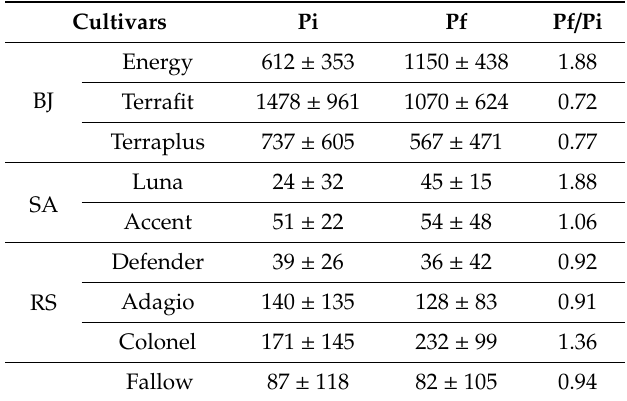
Table 1. Initial (Pi) and final population (Pf) densities and multiplication rates (Pf / Pi) of Meloidogyne hapla for eight cultivars comprising three Brassicaceae species, namely Brassica juncea (BJ), Sinapis alba (SA), and Raphanus sativus (RS), in comparison to black fallow included as control ( n = 4).